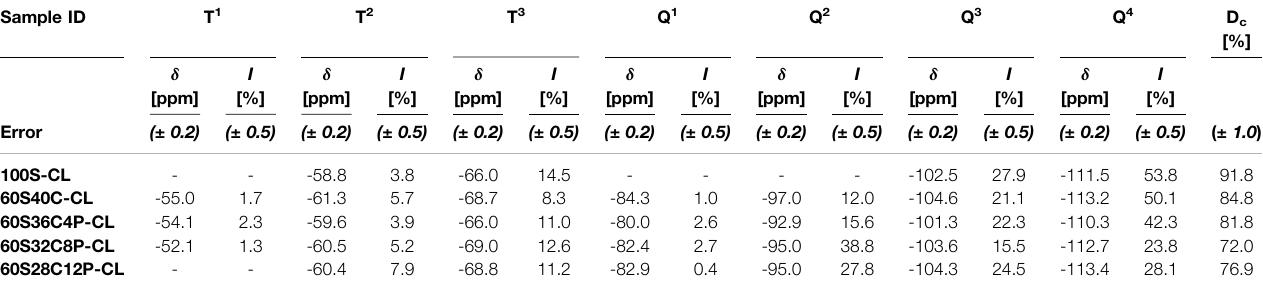
TABLE 2 | Chemical shifts (obtained from 29 Si CPMAS NMR) and percentage abundance (quanti fi ed from 29 Si single-pulse MAS NMR) of silicon T and Q species and the corresponding D c for the SiO 2 -CaO-P 2 O 5 /PTHF/PCL-diCOOH